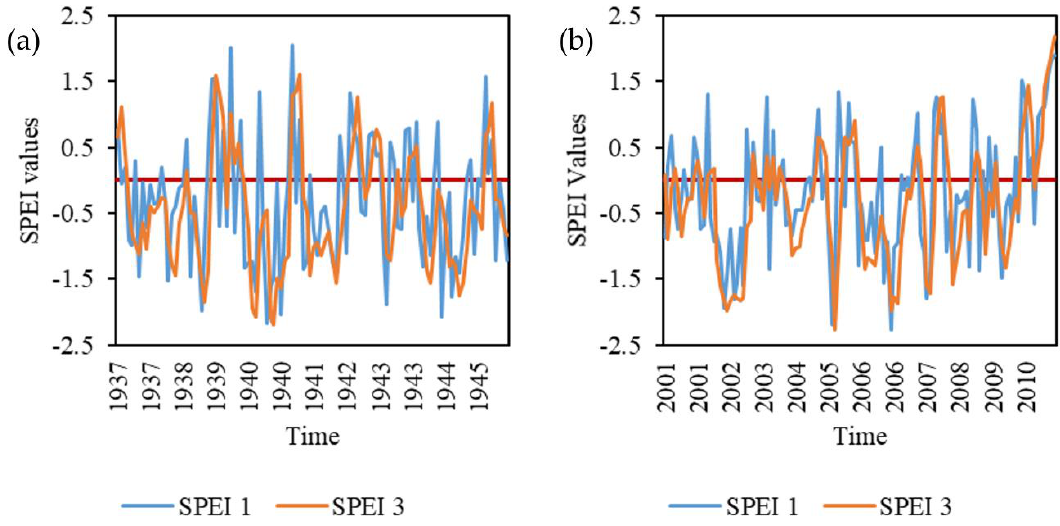
Figure 4. Flowchart of the work being conducted.